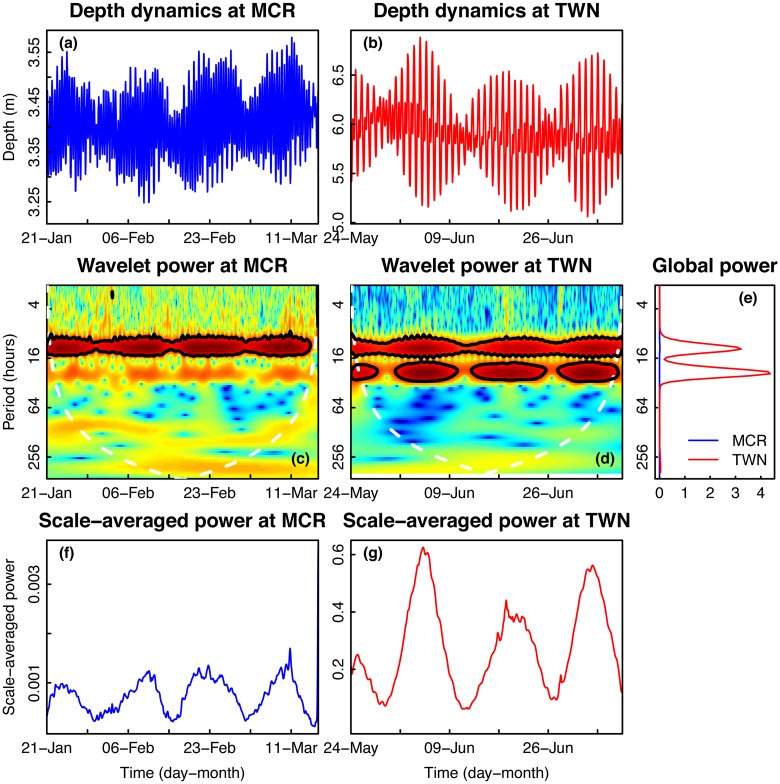
Time series and wavelet power analyses of seawater depth.Time series plots of seawater depth collected on a fringing reef in (a) Moorea [MCR], French Polynesia and (b) Taiwan [TWN]. (c) Distributions of frequencies of depth values during the deployments. Wavelet power quantifies the changes of relative contribution of each period in the depth signal to the overall variance of the signal for time series collected in (c) MCR and (d) TWN. (e) Sites were compared using wavelet power integrated over time. Wavelet power was also integrated over period to describe changes in total variance over time for MCR (f) and TWN (g).